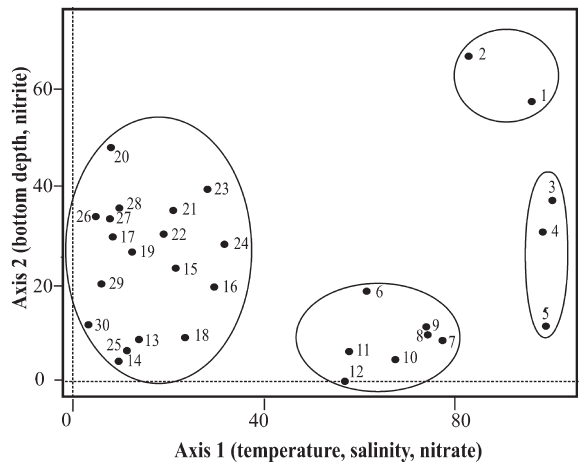
Fig .7. – representation of a Principal component analysis of sta- tions based on environmental variables .